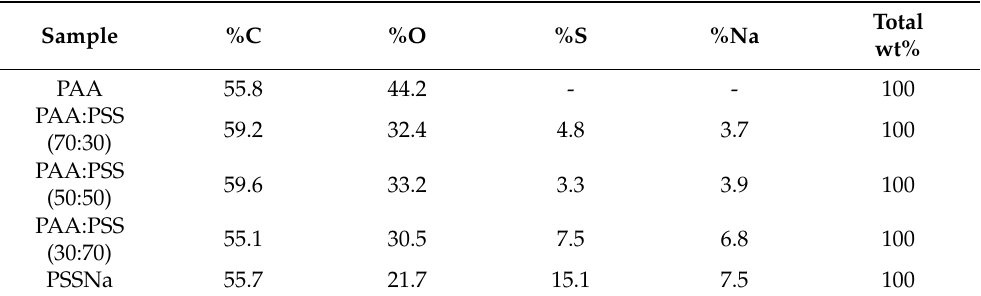
Table 3. EDS measurements on EnPF meshes of PAA and PSSNa homopolymers and PAA:PSS copolymers.